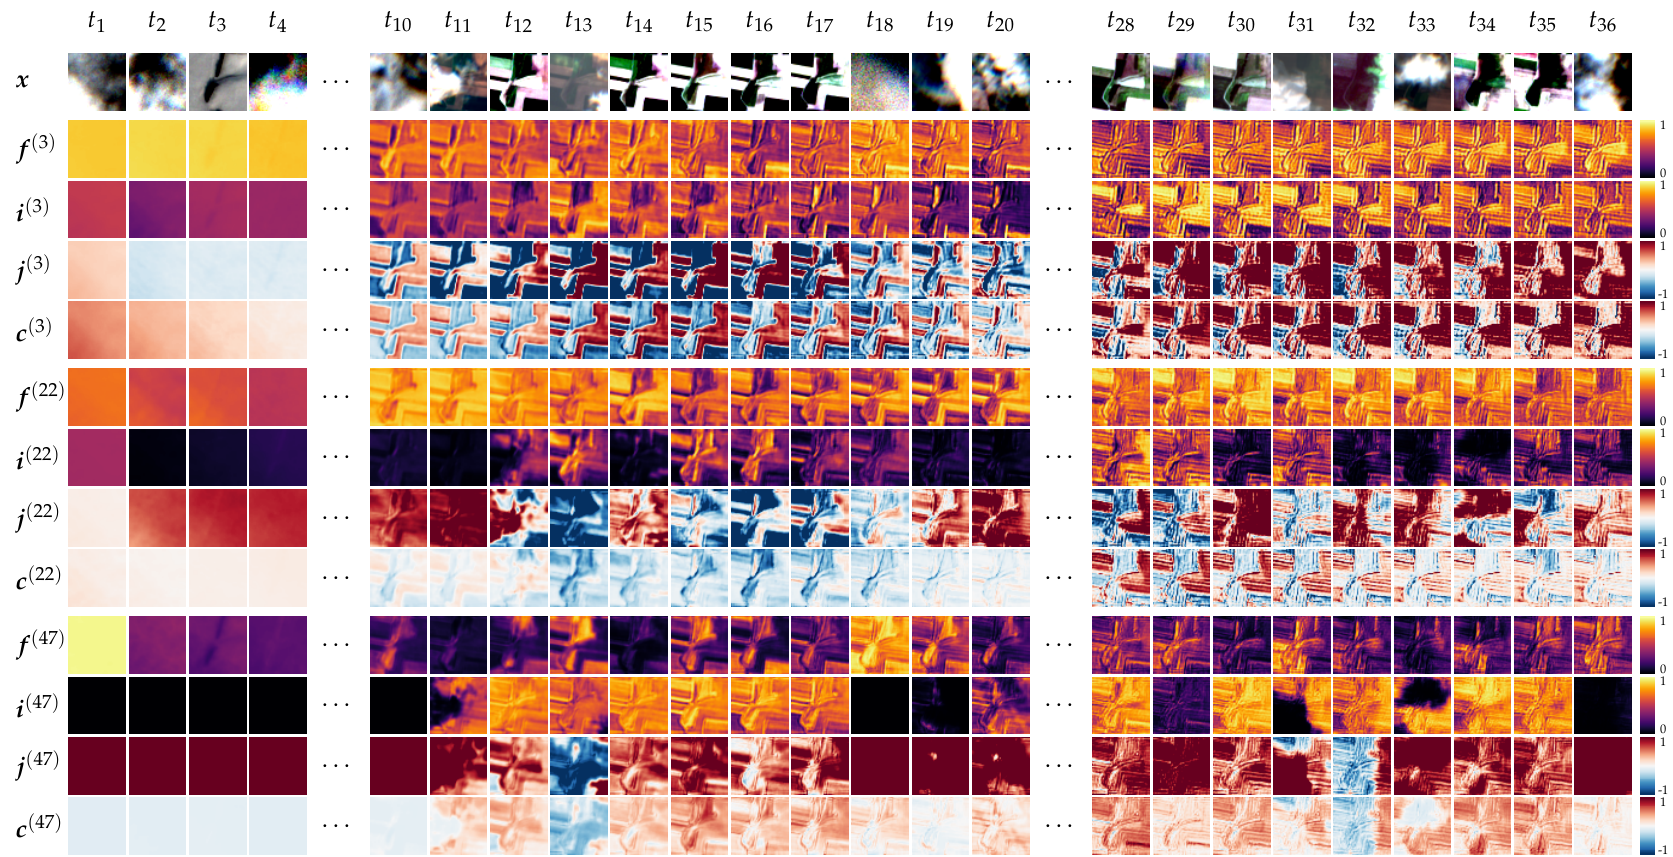
3,22,47 given 3,22,47 given ∈ { } ∈ { }